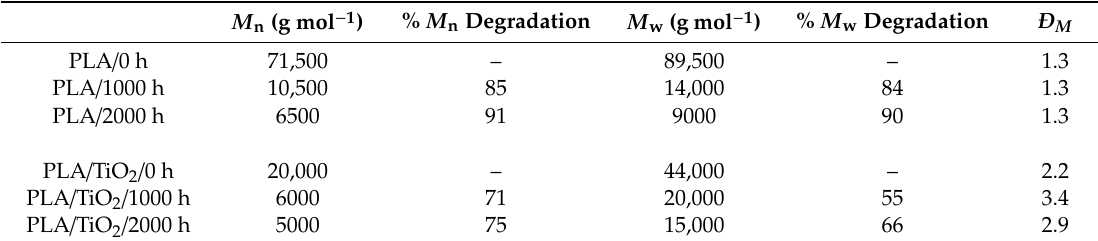
Table 2. Changes in M n , M w and Đ M of the PLA and PLA / TiO 2 samples as a function of accelerated weathering time.